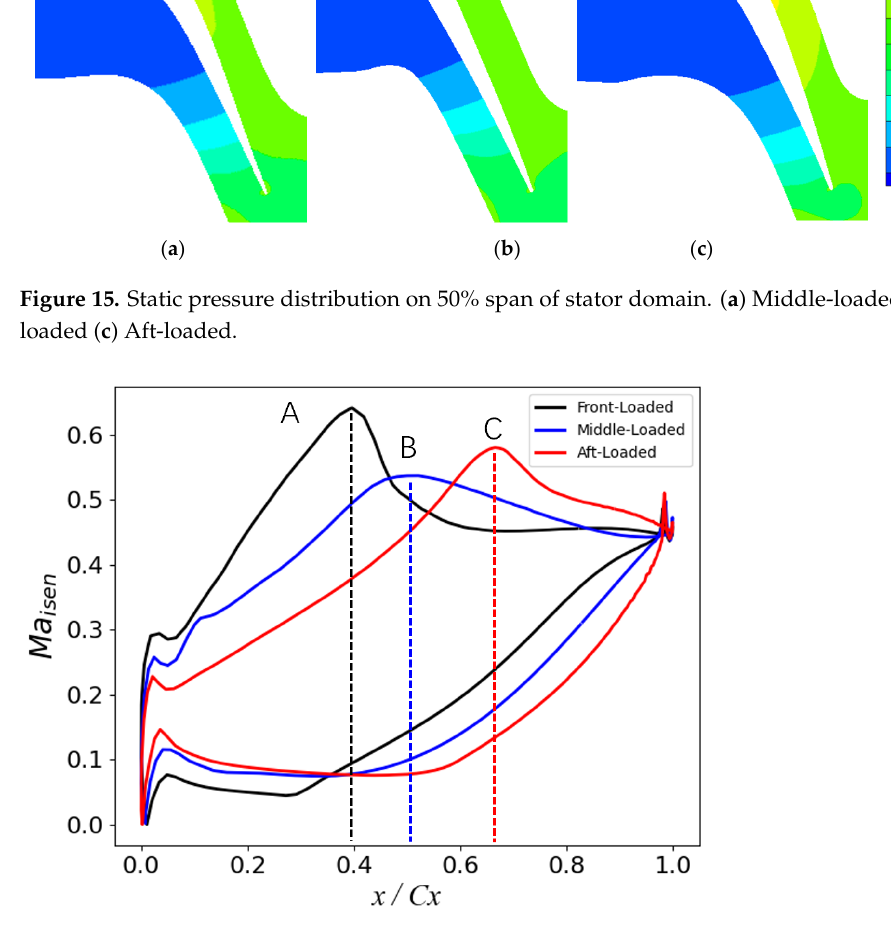
Figure 16. Different loading distribution on three vanes.